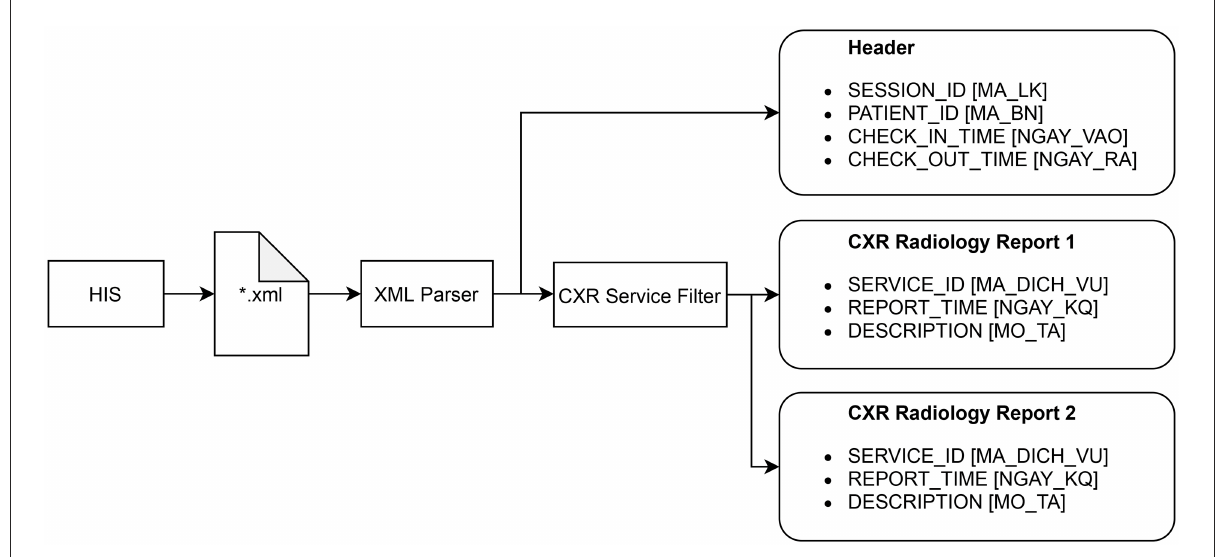
FIGURE3 Procedure for extracting all radiology reports of CXR examinations from HIS. The original names of the attributes, which are in Vietnammese, are put inside square brackets.